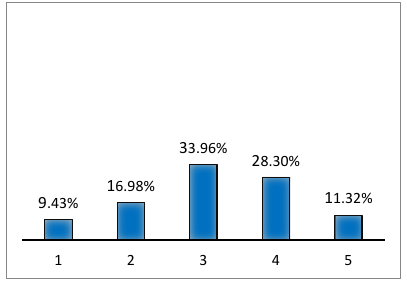
Figure 7. Overall rating of the course quality.